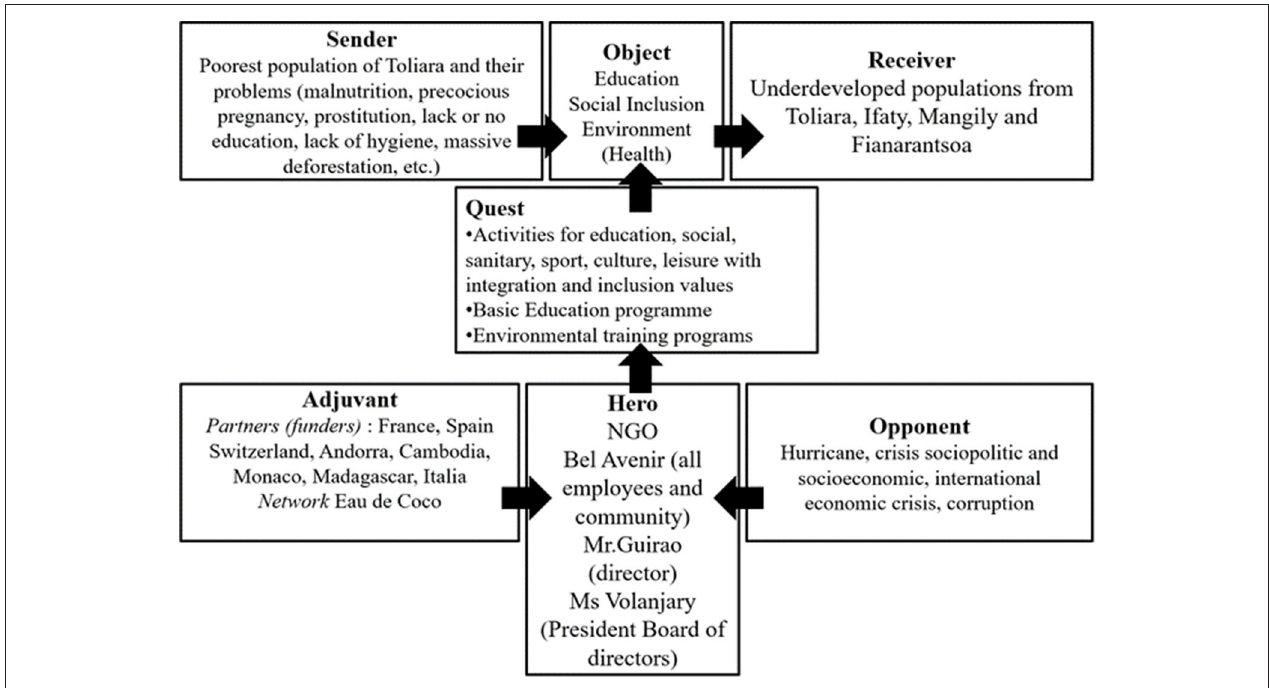
FIGURE 2 | Actantial model of the Bel Avenir NGO and its